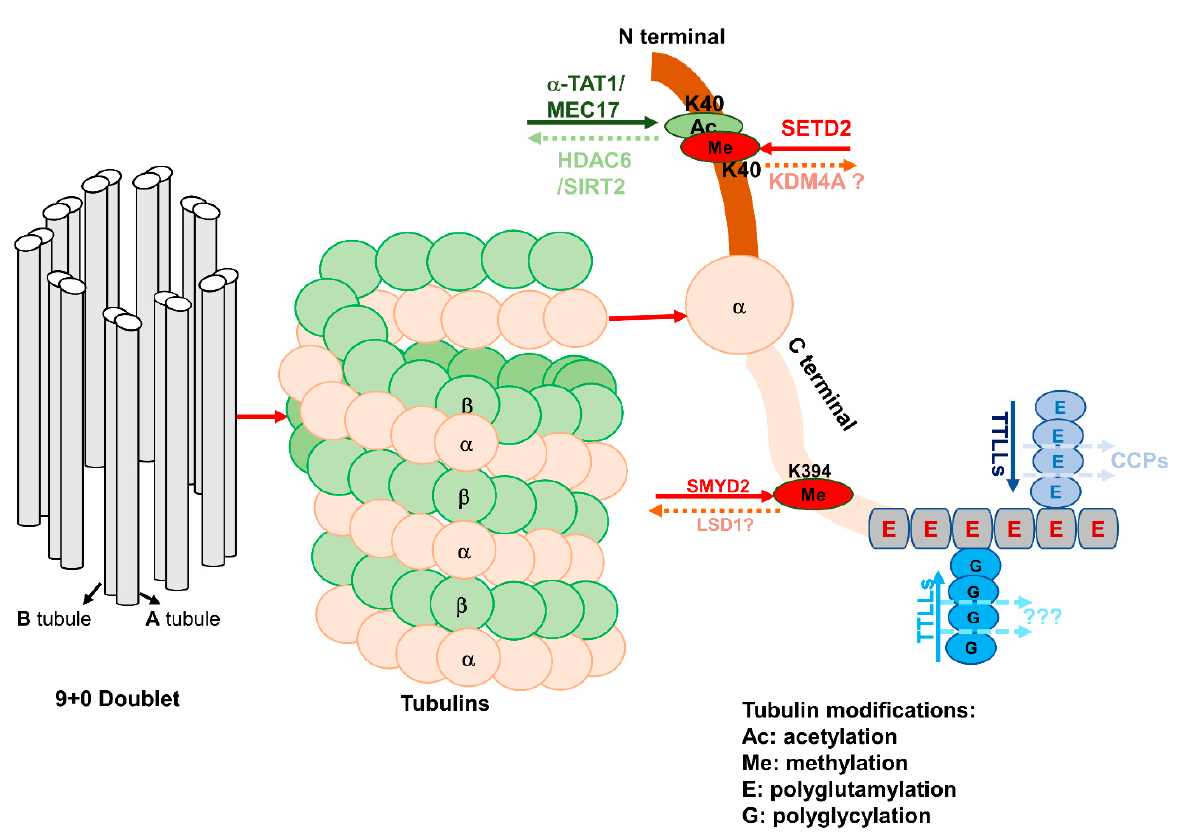
Figure 2. Epigenetic-regulator-mediated tubulin post-translational modifications (PTMs). Left: Schematic drawings of an axoneme composed of 9 doublets (A tubule and B tubule) of microtubules in primary cilia. The microtubules are composed of heterodimers of α -tubulin and β -tubulin. Right: The PTMs of α -tubulin associated with the cell cycle and cilia biogenesis include acetylation, methylation, polyglutamylation, and polyglycylation. Lysine K40 of α -tubulin can be either acetylated by a-TAT1/MEC17 or methylated by SETD2, which can be deacetylated by HDAC6/SIRT2 and possibly demethylated by KDM4A. The acetylation of α -tubulins at K40 occurs on the luminal surface of the microtubules. SMYD2 methylates a-tubulin at K394, which may be demethylated by LSD1. (Poly)glycylation and (poly)glutamylation are found along the glutamate-rich carboxy-terminal tails of α -tubulin, which are regulated by different subsets of tubulin tyrosine